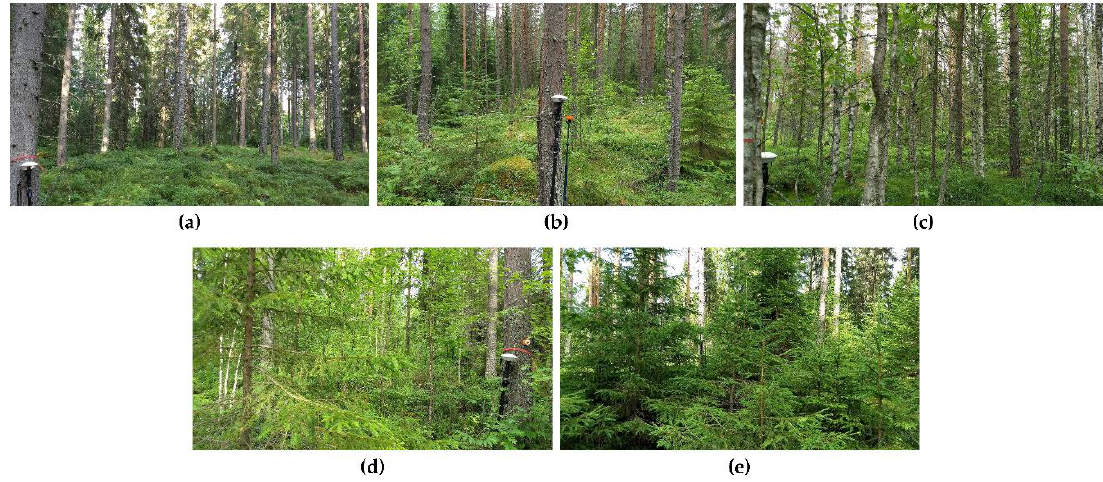
Figure 2. Representative photographs of each category used in the e-questionnaire survey. ( a ) Class 1, no need for pre-harvest clearing; ( b ) Class 2, pre-harvest clearing would help harvesting; ( c ) Class 3, pre-harvest clearing recommended; ( d ) Class 4, a great need for pre-harvest clearing; and ( e ) Class 5, compulsory pre-harvest